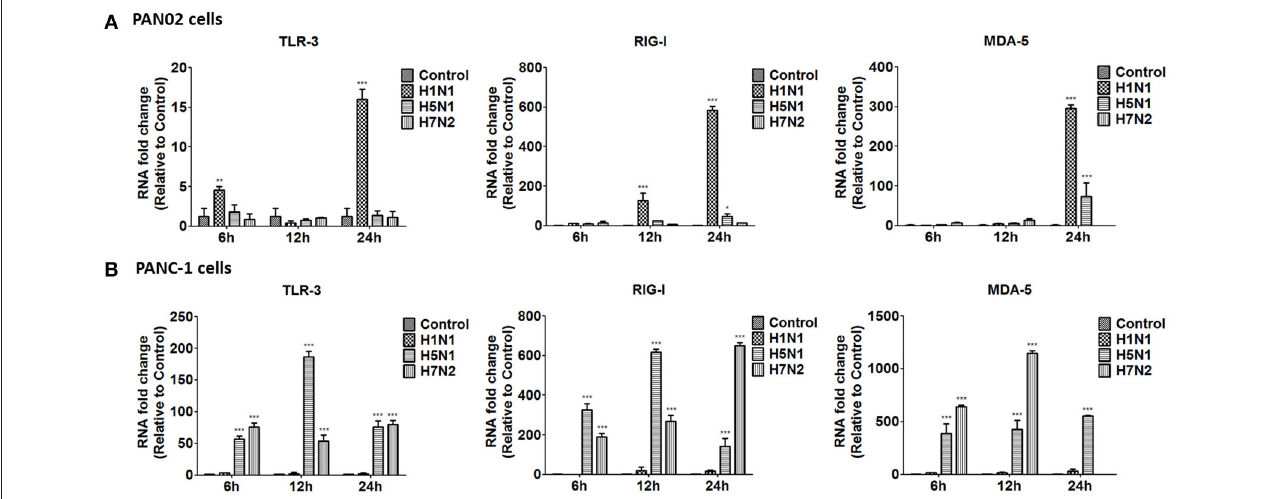
FIGURE 9 | H5N1 IAV upregulates the mRNA expression of Toll-like receptor 3 (TLR3), cytolytic RNA helicases retinoic acid-inducible gene I (RIG-I), and melanoma differentiation-associated gene 5 (MDA-5). (A) PAN02 and (B) PANC-1 cells were treated or infected as described in Figure 5 and harvested at 6, 12, and 24h post-infection. Total RNA was isolated at the designated times and examined by RT-qPCR. The mRNA expression of TLR3, RIG-I, and MDA-5 is shown. The data are presented as the relative fold change over mock treatment. Graphs shown are the mean ± standard deviation (SD) of three independent replicates. Asterisks indicate statistically significant increases compared with mock-treated cells (* P < 0.05, ** P < 0.01, and *** P <